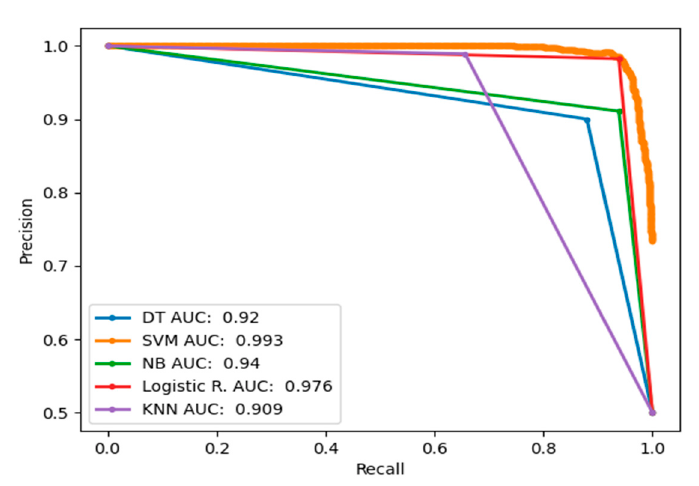
Figure 10. Precision–recall curve (PRC) comparing performances of the classifiers using 4096 FC1 features of the VGG16 model.